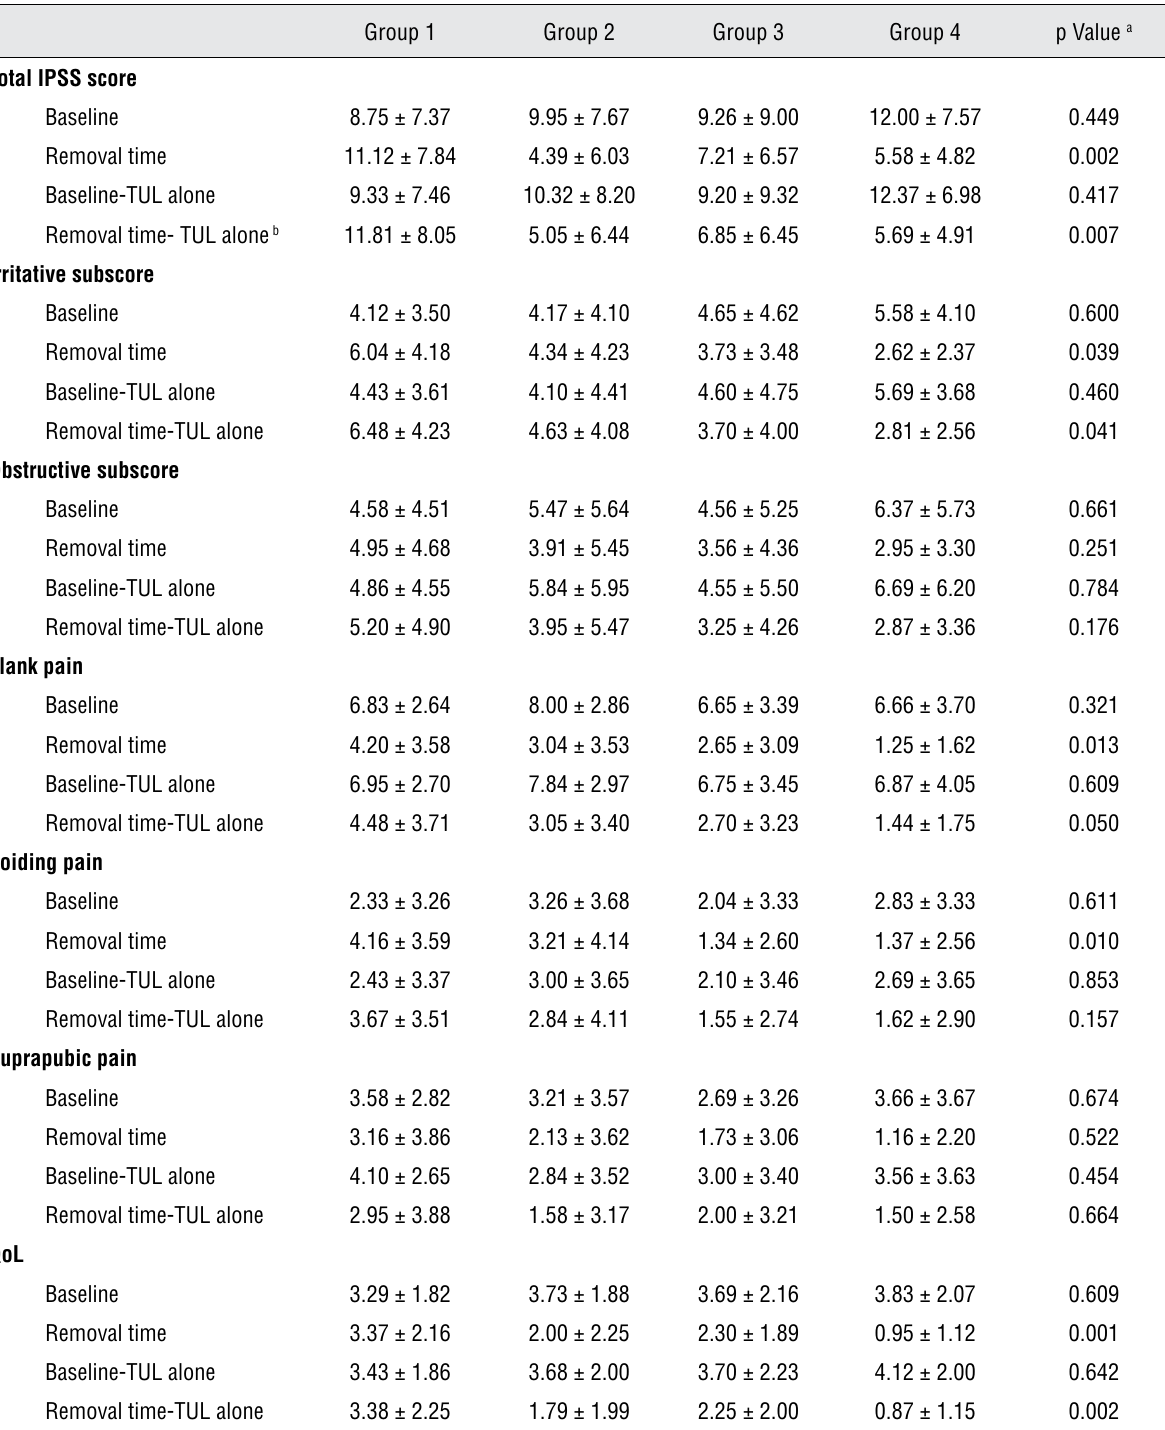
Table 2 - Urinary symptoms, pain and QoL among the